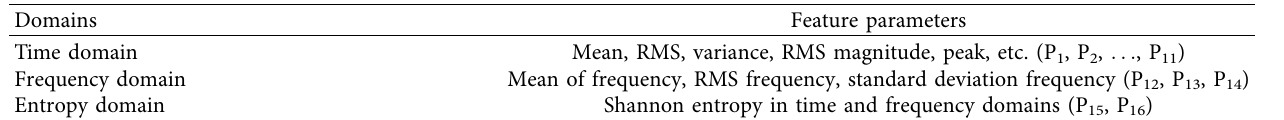
Figure 6: Comparison of vibration signal before and after fltering. (a) Vibration signal before fltering. (b) Vibration signal after fltering. Table 3: List of harmonic reducer test information.